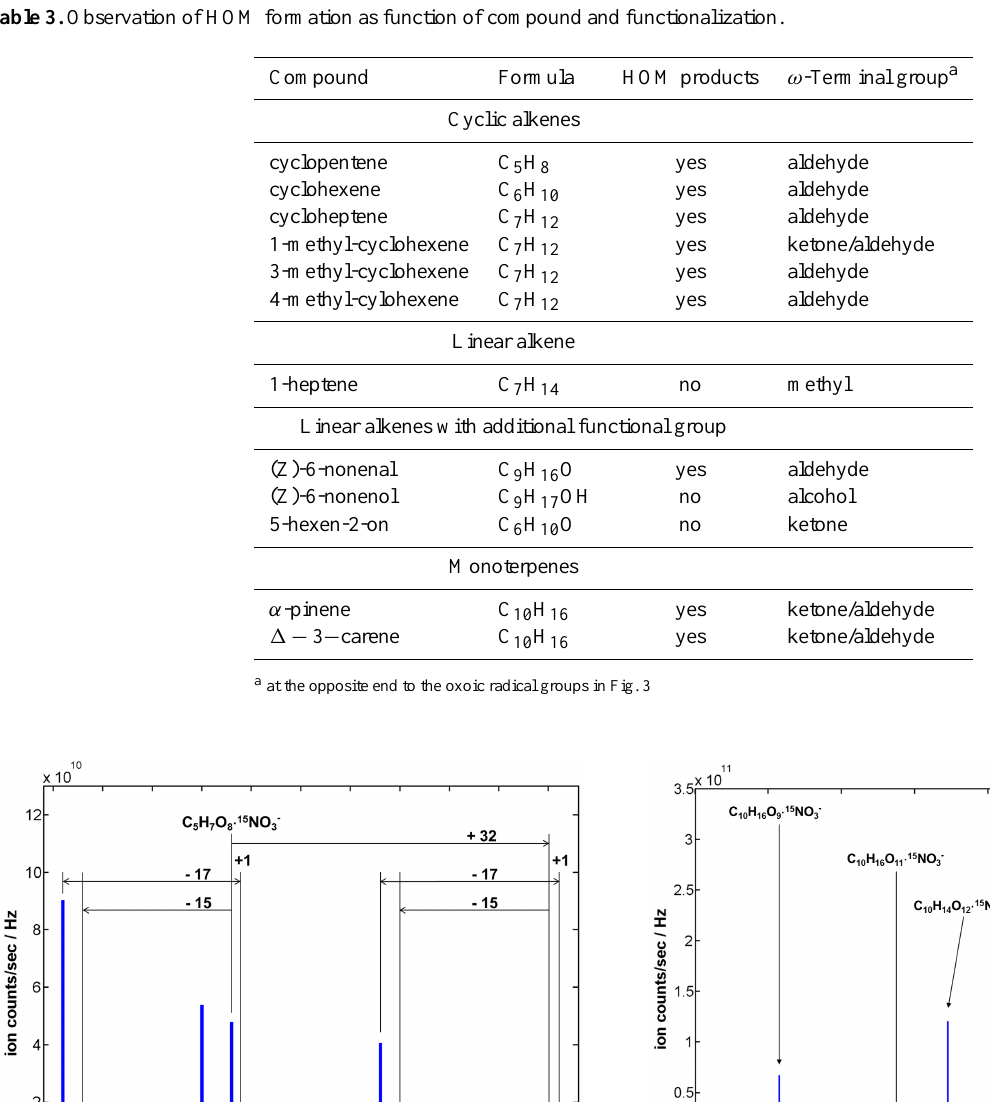
Table 3. Observation of HOM formation as function of compound and functionalization.